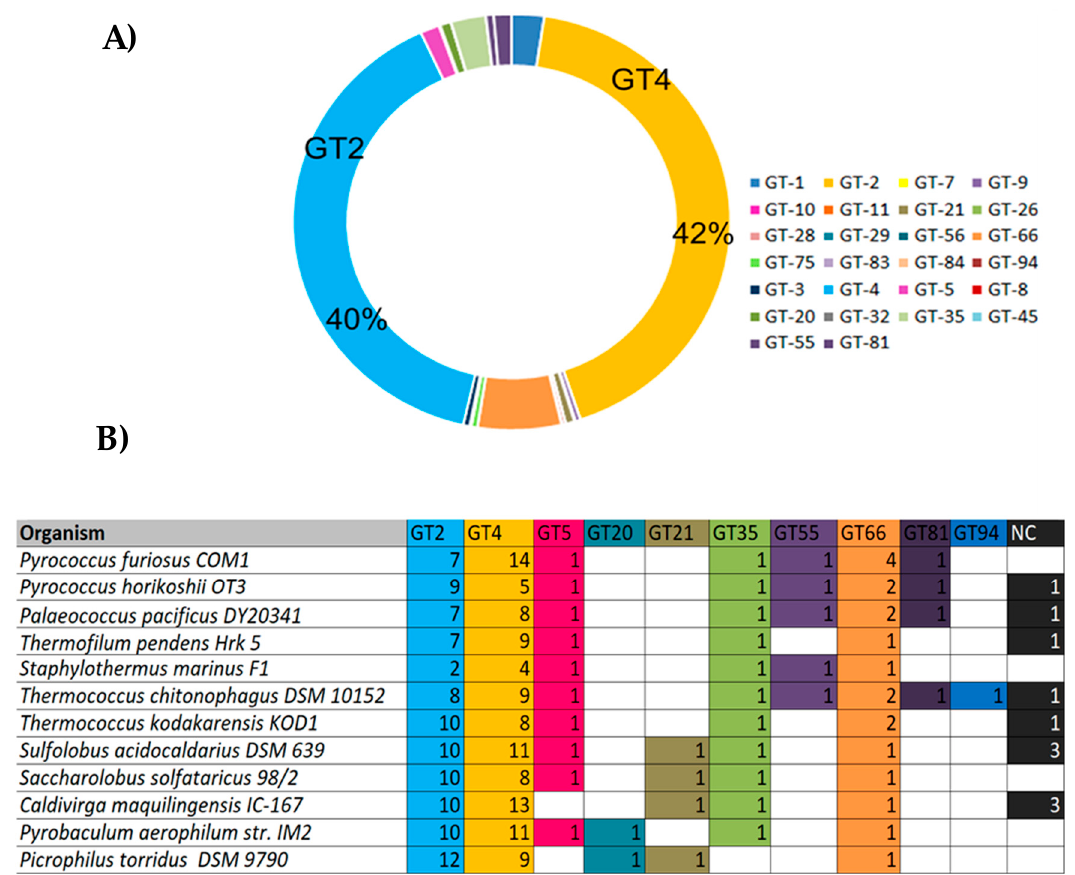
Figure 7. Classification of most abundant archaeal GTs [20]. ( A ) Diagram showing the abundancy of GTs families in Archaea. The sequences from Archaea genomes corresponding to each GT family were retrieved from the CAZY database and the number of occurring sequences for each GT family was determined accordingly; ( B ) Occurrence of GTs in hyperthermophilic Archaea. NC: Non-classified.